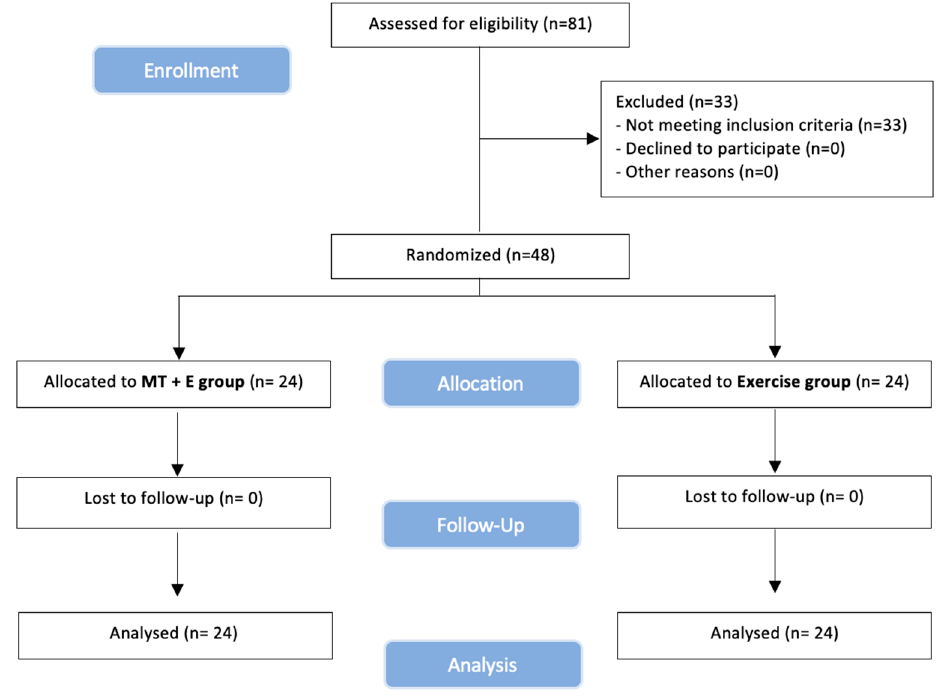
Figure 3. CONSORT . (Consolidated Standards of Reporting Trial) flow diagram.